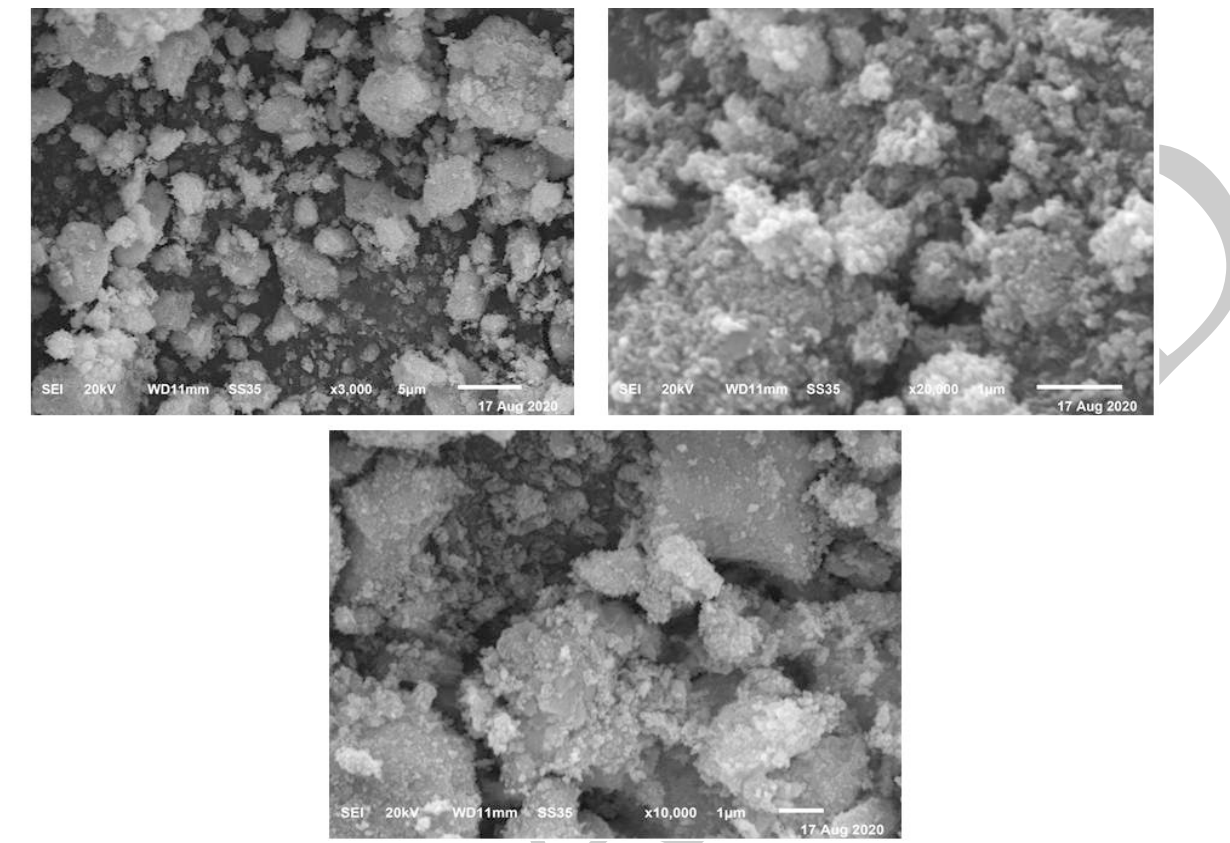
Figure 5. Scanning electron microscopy (SEM) of ZnO nanoparticles (NPs) shows that the size of grains has nearly uniform morphology and appear with a crushed ice-like shape with homogenous size distributions for ZnO NPs.